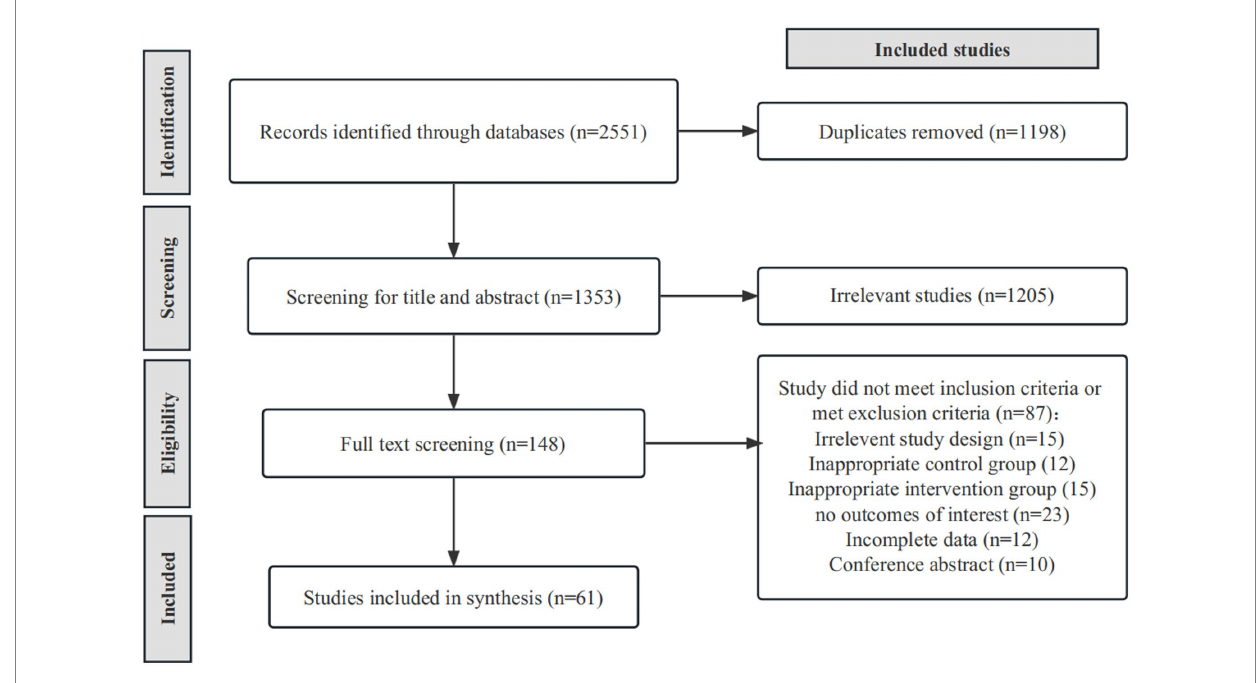
FIGURE 1 PRISMA flowchart illustrating the selection of studies included in our analysis.